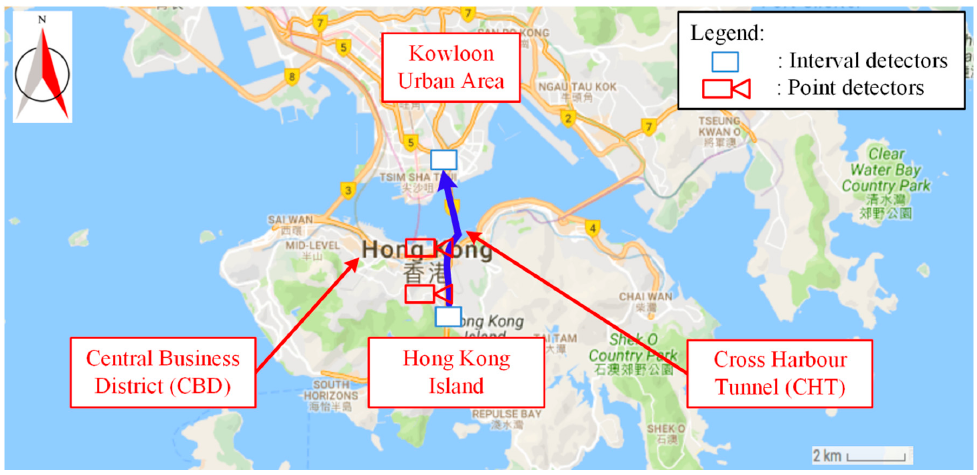
Figure 4. Study area location.